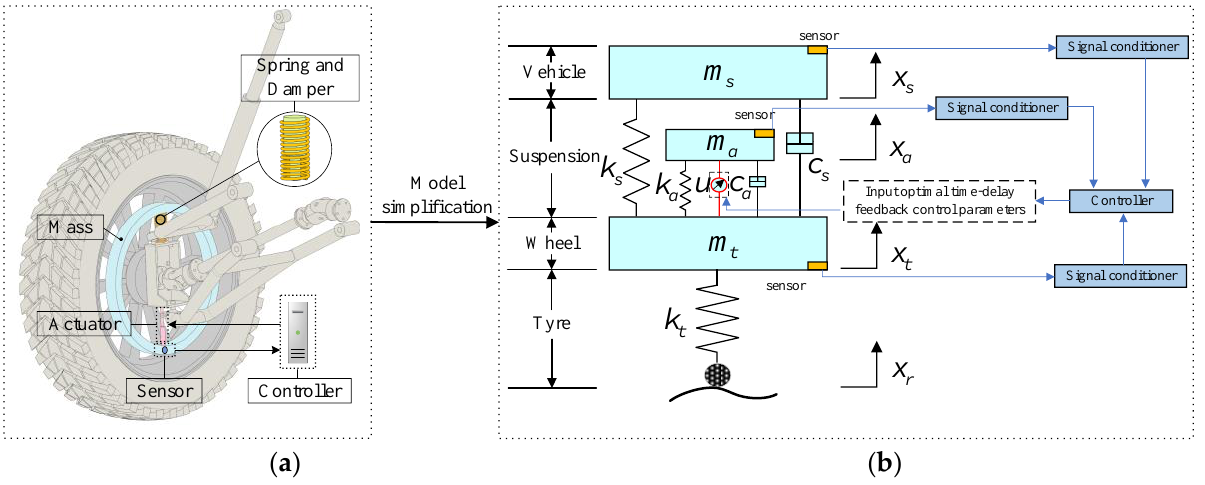
Figure 1. New vibration-absorbing wheel: ( a ) schematic diagram; ( b ) simplified diagram. As shown in Figure 1, m s is the body mass, m t is the wheel mass, and m a is the mass block. k t is the stiffness of the tire. k s and c s are the stiffness and damping coefficients of the suspension; k a and c a are the stiffness and damping coefficients of this new structure; u is the time-delay feedback control force; and x s , x t , x a and x r are the body displacement, tire displacement, mass block displacement and external excitation displacement, respectively.